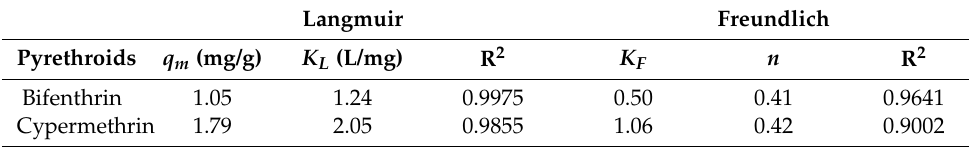
Figure 9. ( a ) Bifenthrin and ( b ) cypermethrin adsorption capacity with Langmuir isothermal fitting and Freundlich isothermal fitting. Table 3. Adsorption isotherm model and parameter values.